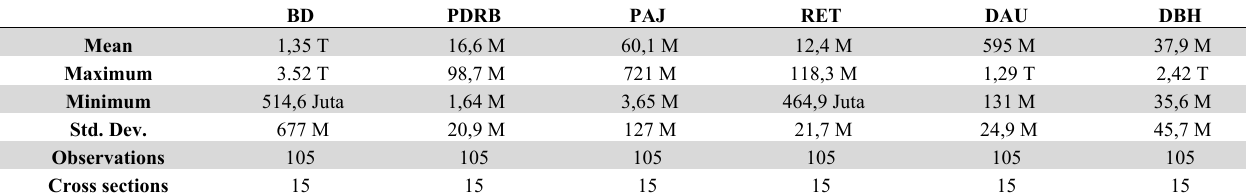
Results of Descriptive Statistics Eq. (1) Model 1